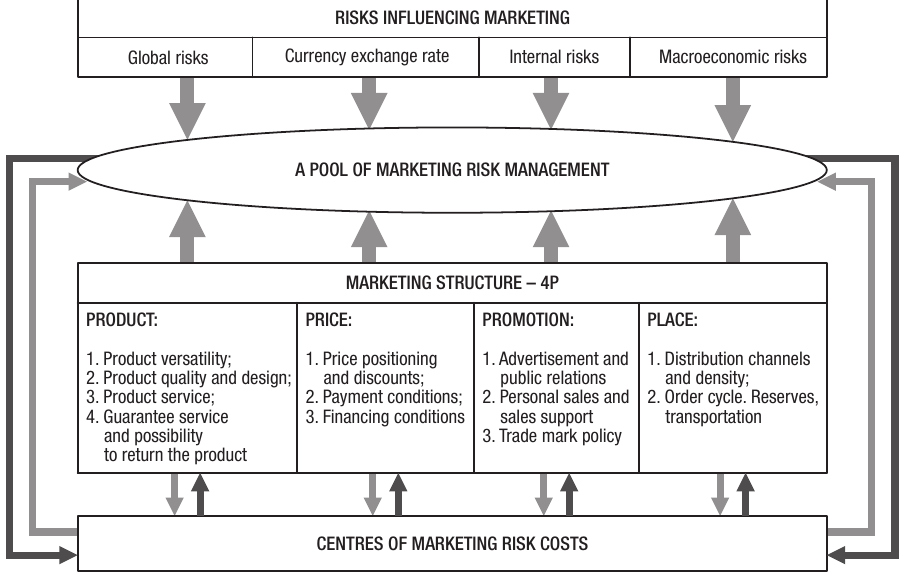
Fig. 2. A scheme of marketing risk management